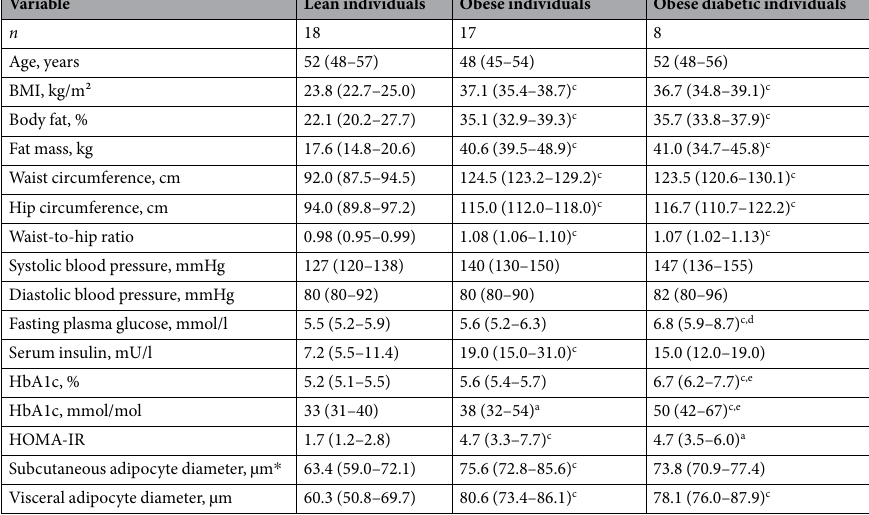
Table 1. Characteristics of obese, obese diabetic individuals and healthy lean controls. Data are median (interquartile range). * Data from 14 lean, 16 obese and 7 obese diabetic individuals. Significantly different from lean group ( a p < 0.05; b p < 0.01; c p < 0.001). Significantly different from obese group ( d p < 0.01; e p <